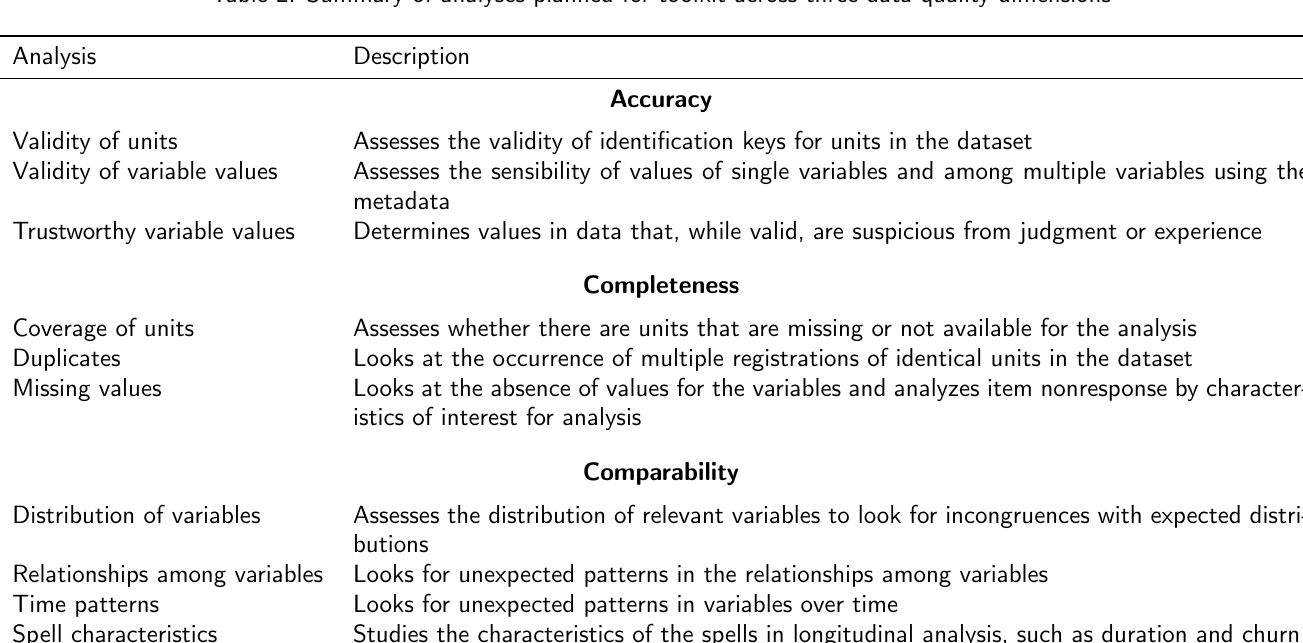
Table 2: Summary of analyses planned for toolkit across three data quality